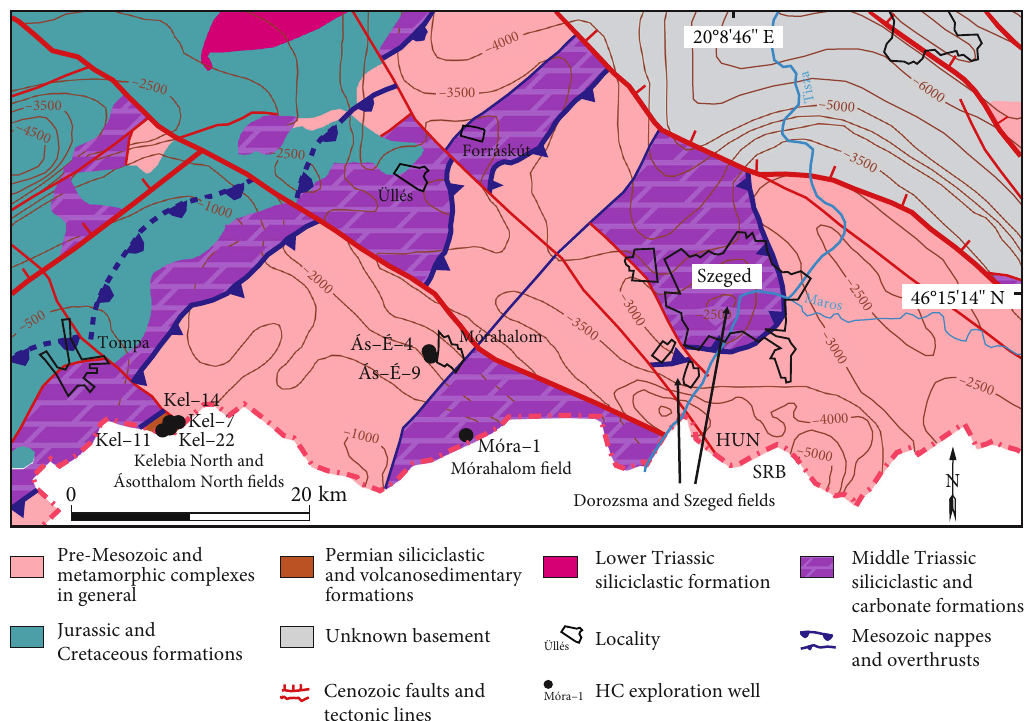
Figure 2: Location of the Kelebia basement area, together with other important HC fi elds in the Szeged Basin, on the generalized geological map of the pre-Cenozoic basement formations [14, 24]. Isoline numbers are in meters, showing basement depths and highs. Abbreviations: HUN: Hungary; SRB: